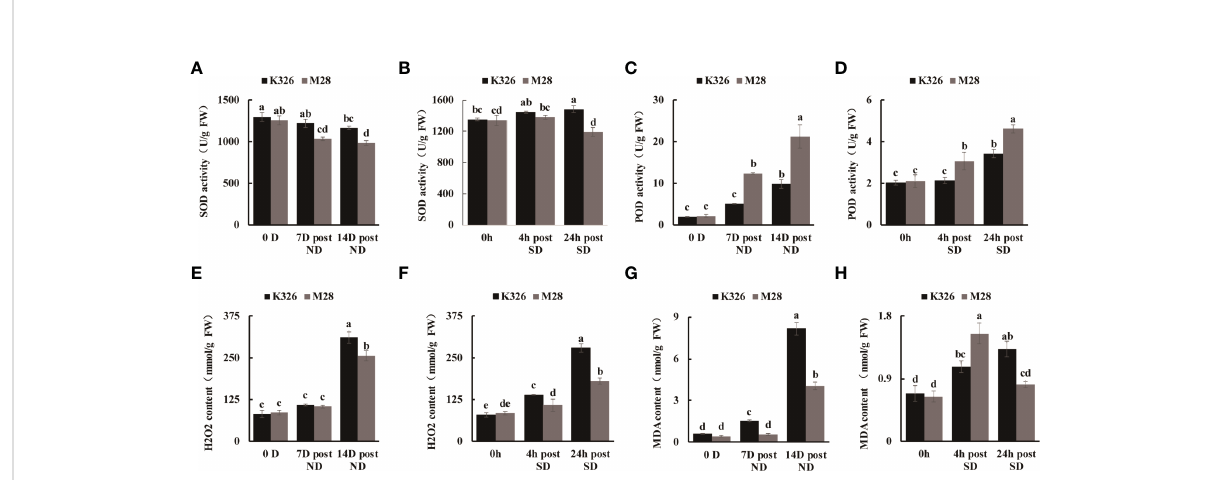
FIGURE 1 Biochemical comparisons between tobacco K326 and M28 at different time points after exposing to ND and SD, respectively. (A, B) SOD activity at 0 D,7 D,14 D post ND, and 0h,4h,24h between tobacco K326 and M28. (C, D) POD activity at 0 D,7 D,14 D post ND, and 0h,4h,24h between tobacco K326 and M28. (E, F) H2O2 content at 0 D,7 D,14 D post ND, and 0h,4h,24h between tobacco K326 and M28. (G, H) MDA content at 0 D,7 D,14 D post ND, and 0h,4h,24h between tobacco K326 and M28. Different letters represent signi fi cant differences (P< 0.05, one-way ANOVA).The difference is not signi fi cant if there is a letter with the same marker, and signi fi cant if there is a letter with a different